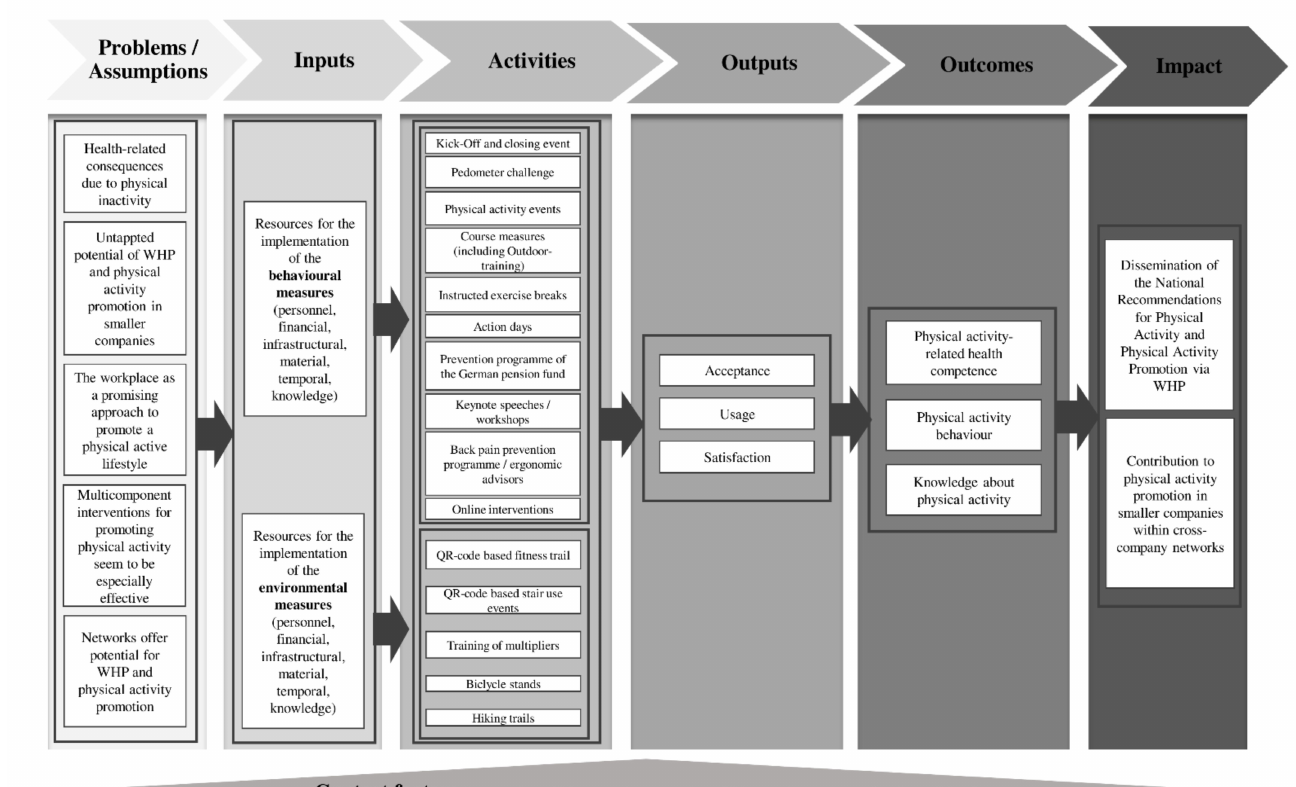
Figure 1. Logic model of KomRueBer study (individual